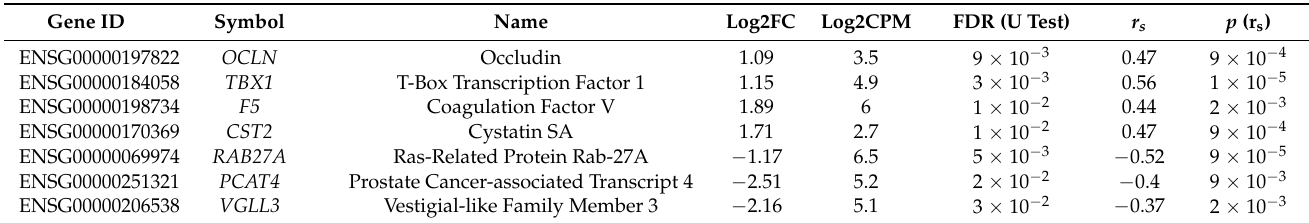
Table 2. Differential expression of promising genes as markers of lymphatic dissemination based on a sample of Russian patients with